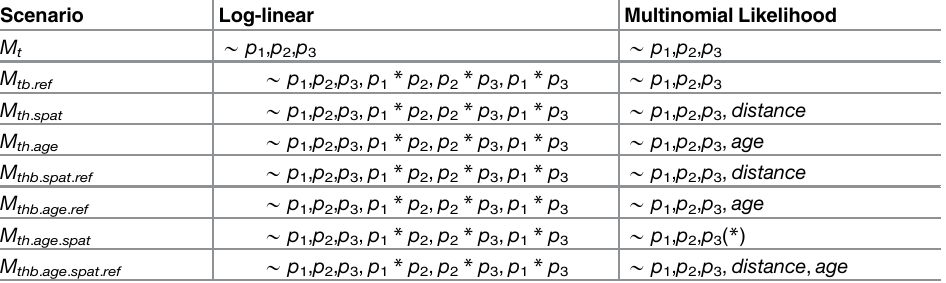
Table 2. Models selected by AIC. For log-linear models a selection was made out of all hierarchical models. For the multinomial models a selection was made out of all possible models, including those with probabilities conditional on covariates and mixtures. p 1 = p(sentinel), p 2 = p(hospital), p 3 = p(NRC), distance in meters, age in days. ( * ) parameters for the age and distance covariates were not estimable. Scenario Log-linear Multinomial